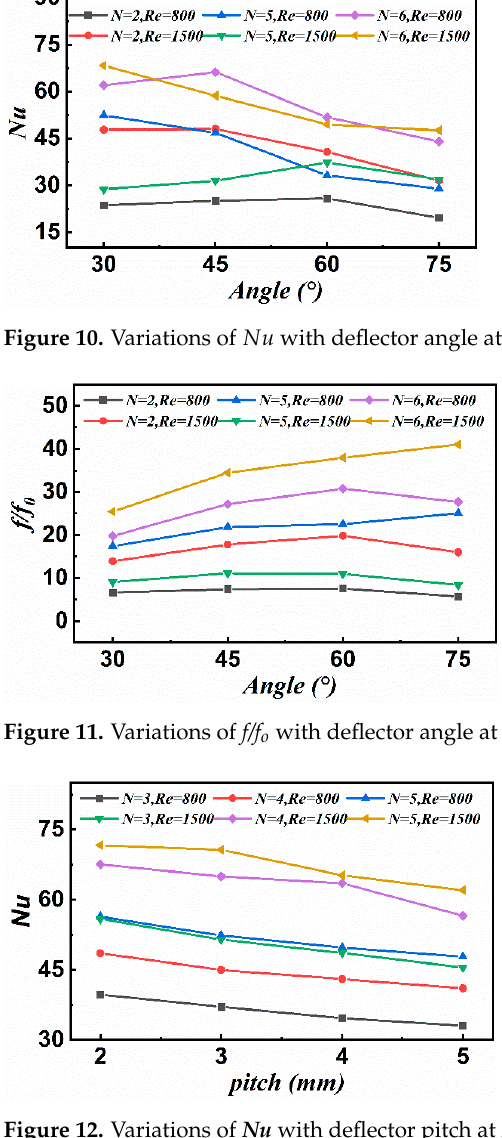
Figure 13. Variations of f/f o with deflector pitch at A = 30°. Figure 14. Temperature contour and helicity at Z = 61mm plane (P=2, 3, 4, 5 mm, N = 3, A = 30°, 𝑅𝑒 = 1200) Significance Comparison of Influencing Factors To analyze the influence of different factors on heat transfer and pressure drop, the CFD results were analyzed by partial least squares regression (PLS). For more information on PLS, see supporting materials. The Reynolds number is the most significant factor af- fecting the heat transfer and pressure drop, far more than the structure parameters, as shown in Figure 15, since the flow velocity directly affects the intensity of the generated vortices and the thickness of the boundary layer. Among the structure parameters, the